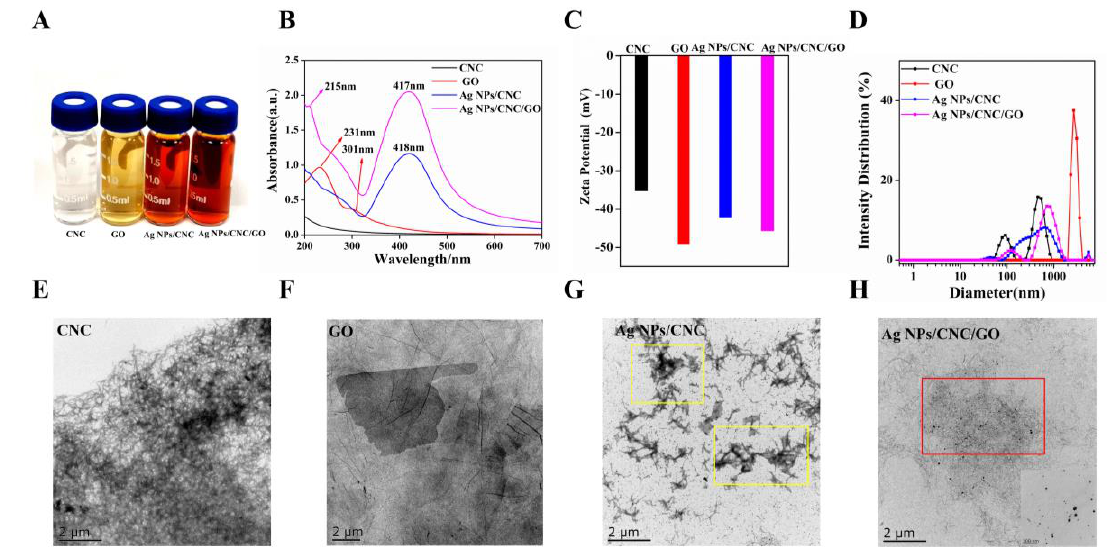
Figure 2. Characterization of CNC, GO, Ag NPs/CNC and Ag NPs/CNC/GO suspensions. ( A ) Optical images (from left to right). ( B ) UV-Vis absorption spectra. ( C , D ) Zeta potential of the suspensions and the corresponding size distribution changes. ( E – H ) respectively showed the respective TEM images, where the inset in ( H ) was a corresponding enlarged image.